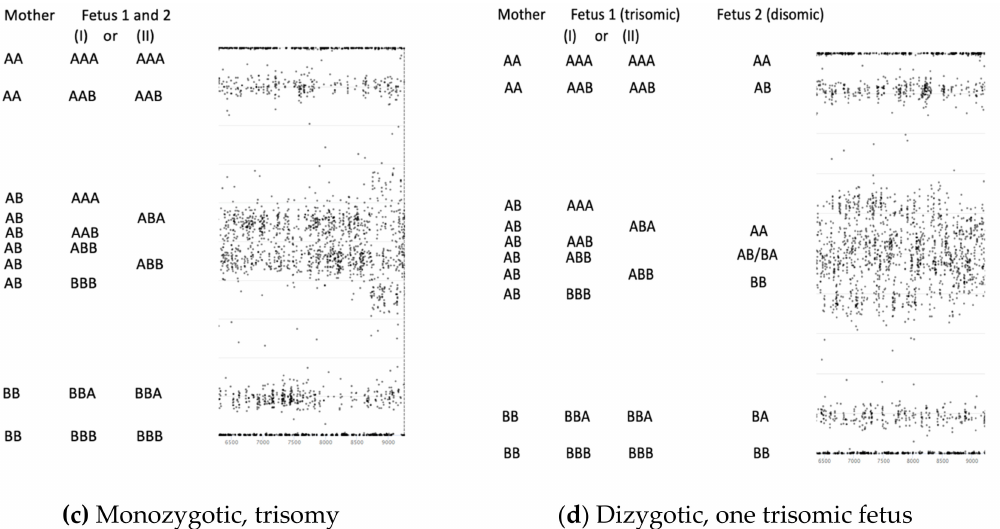
Figure 1. Heterozygosity plots for SNP alleles for a single chromosome in twins. Legend: x -axis— relative position of the SNP along the chromosome; y -axis—relative amount of the alleles (100% A at the top and 100% B allele at the bottom). ( a ) The pattern of SNPs in monozygotic twins is the same as in singleton pregnancies as there are only two di ff erent genotypes present. The relative vertical position of heterozygous alleles is determined by the fetal fraction, with two SNP bands at the top, three in the middle, and two at the bottom. ( b ) Dizygotic twins share zero, one, or two homologous regions of their genomes, depending on the recombination and inheritance patterns. The pattern for dizygotic twins di ff ers from monozygotic twins over those regions where the twins share zero or one homologous regions due to the extra genotype present in the DNA mixture. Over those regions, there are more possible combinations alleles at a given SNP, meaning more bands. In this example, the fetal fraction for fetus 1 is less than that for fetus 2. ( c ) When trisomy is present in a monozygotic twin pregnancy, the number of bands change, with the number depending on the number of homologous regions from each parent. The pattern is similar to a singleton pregnancy where trisomy is present. Two alternative fetal genotypes are shown; I depict the situation where two homologs are inherited from the father, or where two identical homologs are inherited from the mother, and II is where one of each of the maternal homologs are present in the fetus. The pattern can change along the chromosome as a result of recombination. ( d ) The combination of a trisomy and disomy in a dizygotic twin pregnancy results in a complex pattern. Although more complex, the informatics can compute the two FFs and determine the presence of trisomy through comparison of relative SNP amounts across